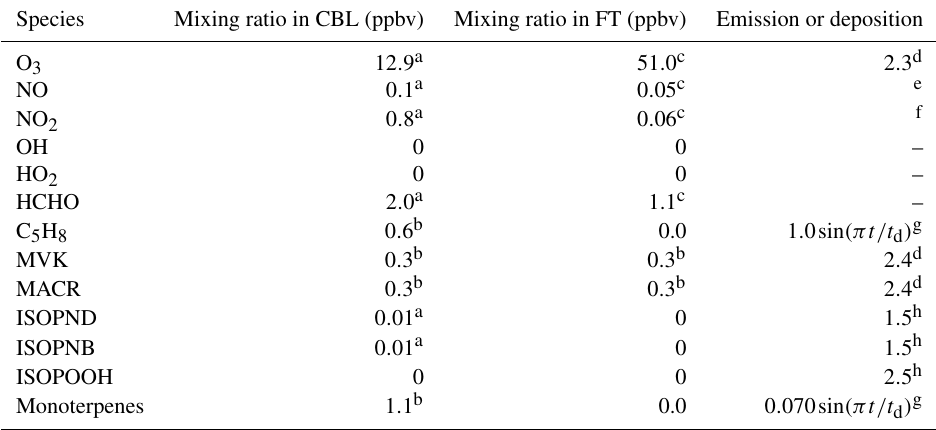
− 1 in reduced d ) pptvms